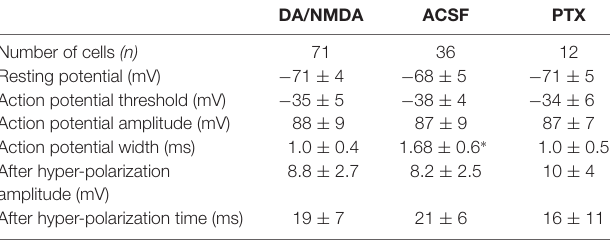
∗ p < 0.05. Only neurons for which reliable action potential measures were obtained are listed.